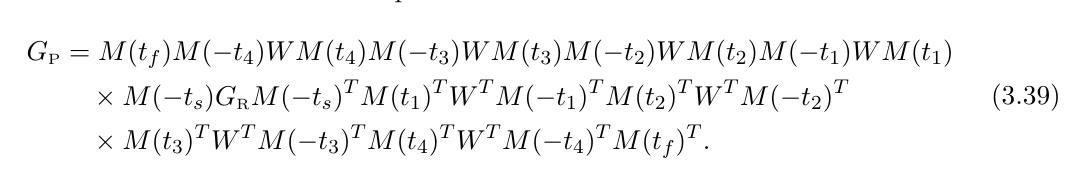
Figure 9 . log ρ and log ρ 0 vs time for the figure on the left. Relative error (log ρ 0 P P vs time for the figure on the right. The parameters are set as ωt 1 = ωt 3 = − ωt s = − ωt f = 20 , δω/ω = 10 − 3